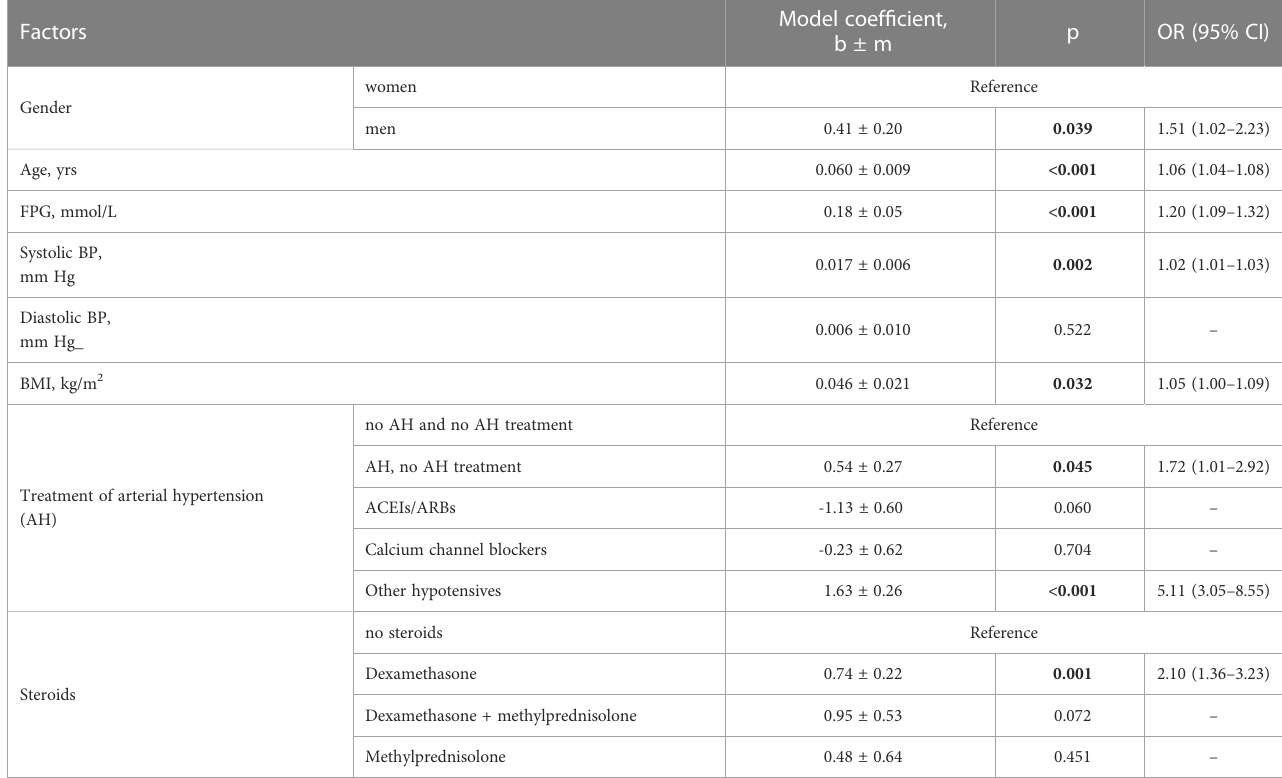
TABLE 3 Risks of death of COVID-19 inpatients without diabetes mellitus (n=947) estimated using one-way logistic regression models.